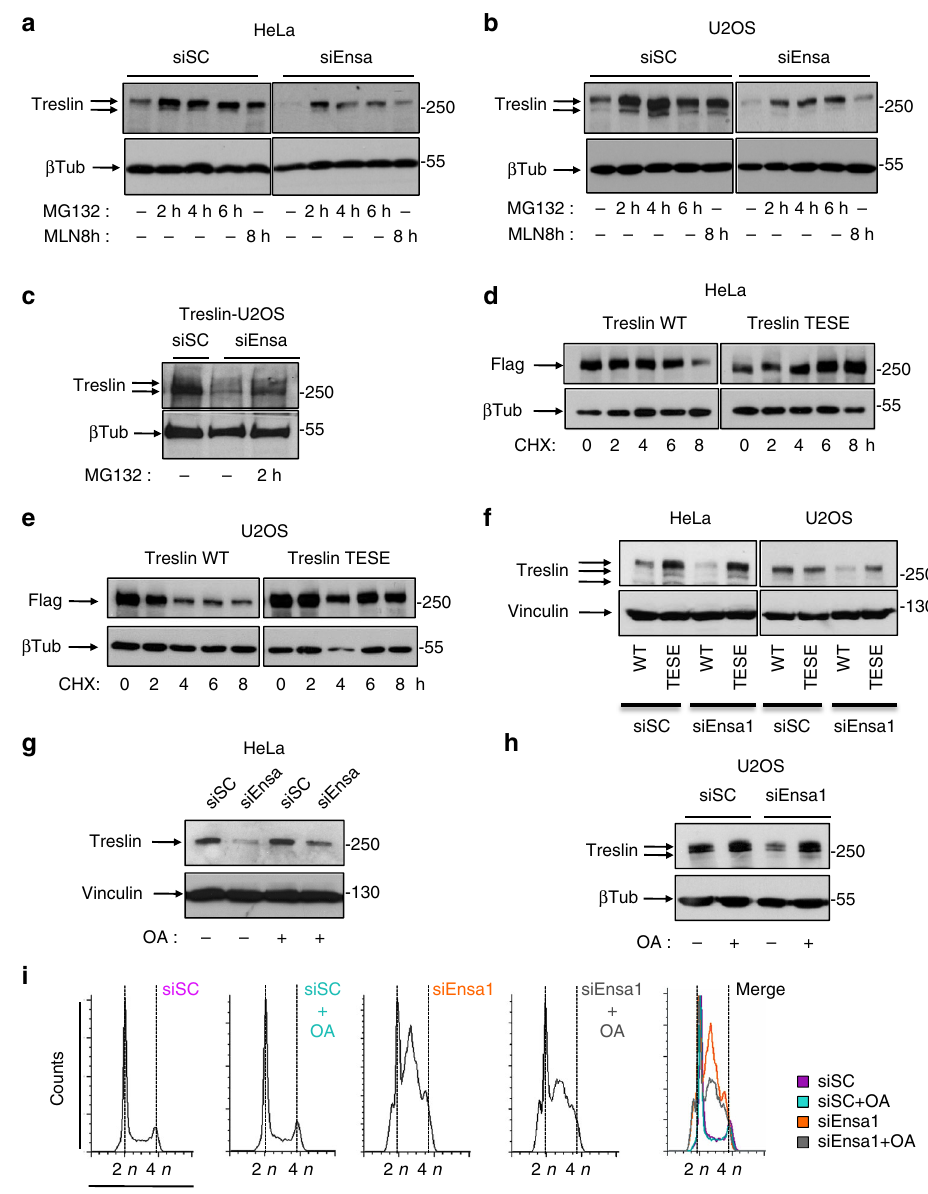
Fig. 9 Ensa impedes the Cullin-dependent degradation of Treslin by preventing its dephosphorylation by PP2A. a Parental HeLa cells were treated with siSC or siEnsa and subsequently incubated for 6 h without ( − ) MG132, for 2, 4 or 6 h with MG132 (10 µ M) or for 8 h with MLN4924 (500 nM) and subsequently recovered for western blot analysis. β -Tubulin levels were used as a loading control. b As for a , except that U2OS cells were used. c U2OS cells stably expressing Treslin cDNA were transfected with siSC or siEnsa and subsequently incubated with (2 h) or without ( − ) MG132 (10 µ M) and Treslin amount checked by western blot. d HeLa cells overexpressing a Flag-tagged wild-type (WT) Treslin or the phosphomimetic mutant of this protein T968E/S1000E (TESE) were incubated with cycloheximide for the indicated periods of time and submitted to western blot to measure ectopic Treslin levels. e As for d , except that U2OS instead of HeLa cells were used. f HeLa and U2OS cells were co-transfected with Flag-tagged wild type or the T968/ S1000E Treslin mutant and treated with siSC or siEnsa and used for western blot to measure ectopic Treslin levels g HeLa cells were transfected with scramble (siSC) and Ensa (siEnsa) siRNAs and 24 h later incubated (+) or not ( − ) with the PP2A inhibitor okadaic acid (OA; 5 nM). Cells were recovered 24 h later and used for western blot. h As for g , except that U2OS instead of HeLa cells were used. i FACs analysis for HeLa cells in g is shown